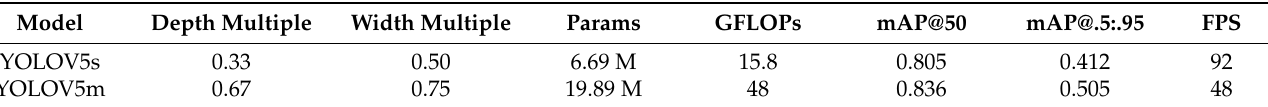
Table 1. Comparison of the training results of YOLOV5s and YOLOV5m.